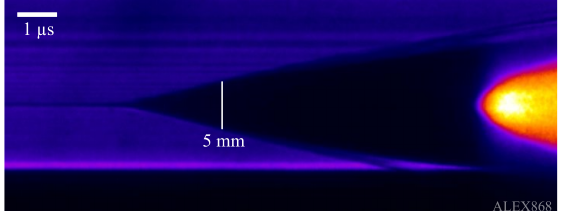
Figure 3. Typical streak image photo in false colors. In this experiment, an iron wire was exploded with a charging voltage of 10 kV in the capacitors bank. The total sweep time is 20 µ s. The dark part of the image corresponds to the metal gas expanding, and the more luminous part at the end is the beginning of plasma formation. The horizontal dimension is the time at which the radial expansion, vertical dimension, is